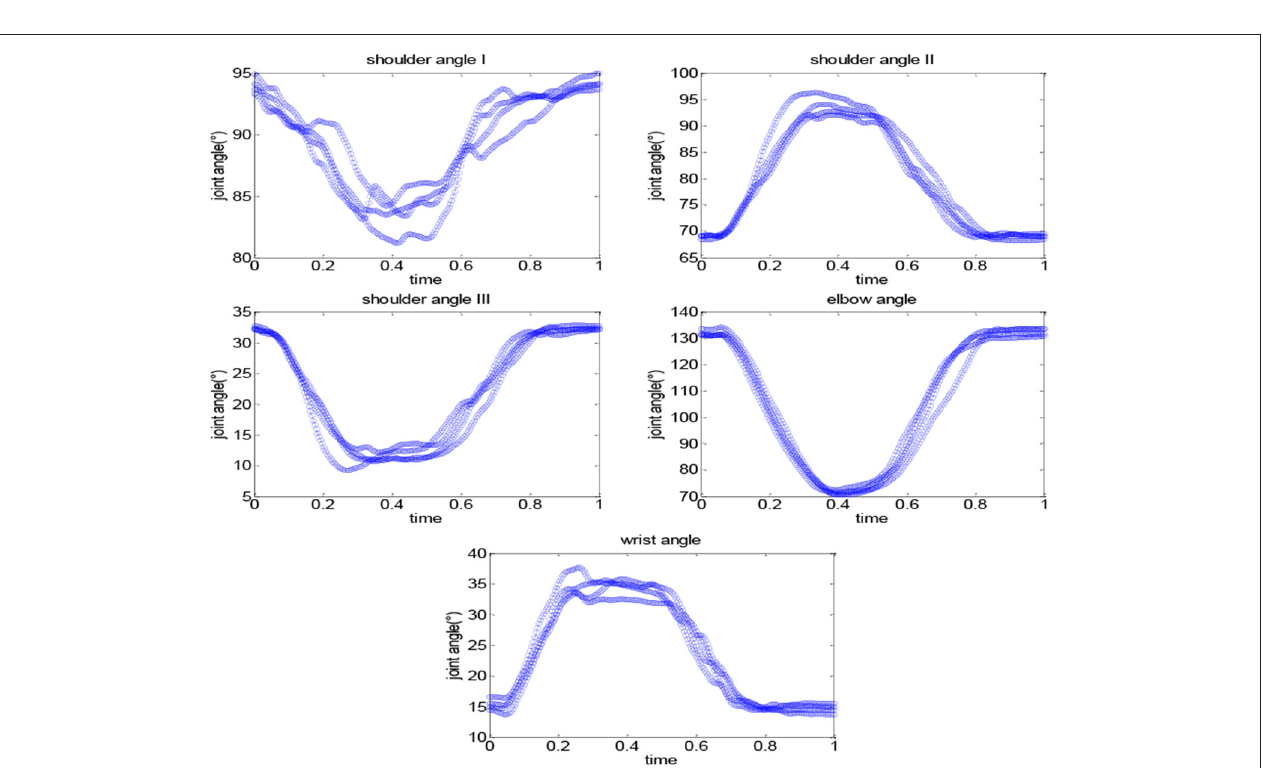
FIGURE 10 | The changes of the shoulder, elbow, and wrist angles of subject S1 under Task 1: drinking water.